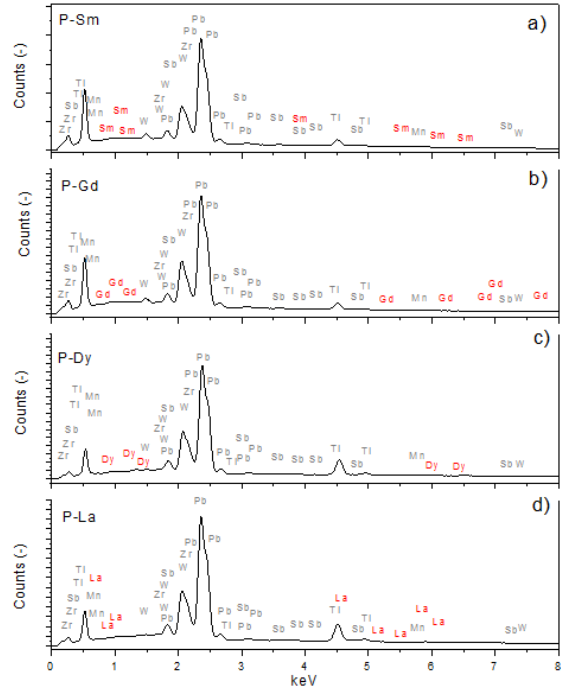
Figure 4. The EDS analysis of the element distribution for the multicomponent PZT-type ceramics. ( a ) P-Sm, ( b ) P-Gd, ( c ) P-Dy, ( d ) P-La. Table 2. Theoretical and experimental percentages of elements of PZT-type ceramics.